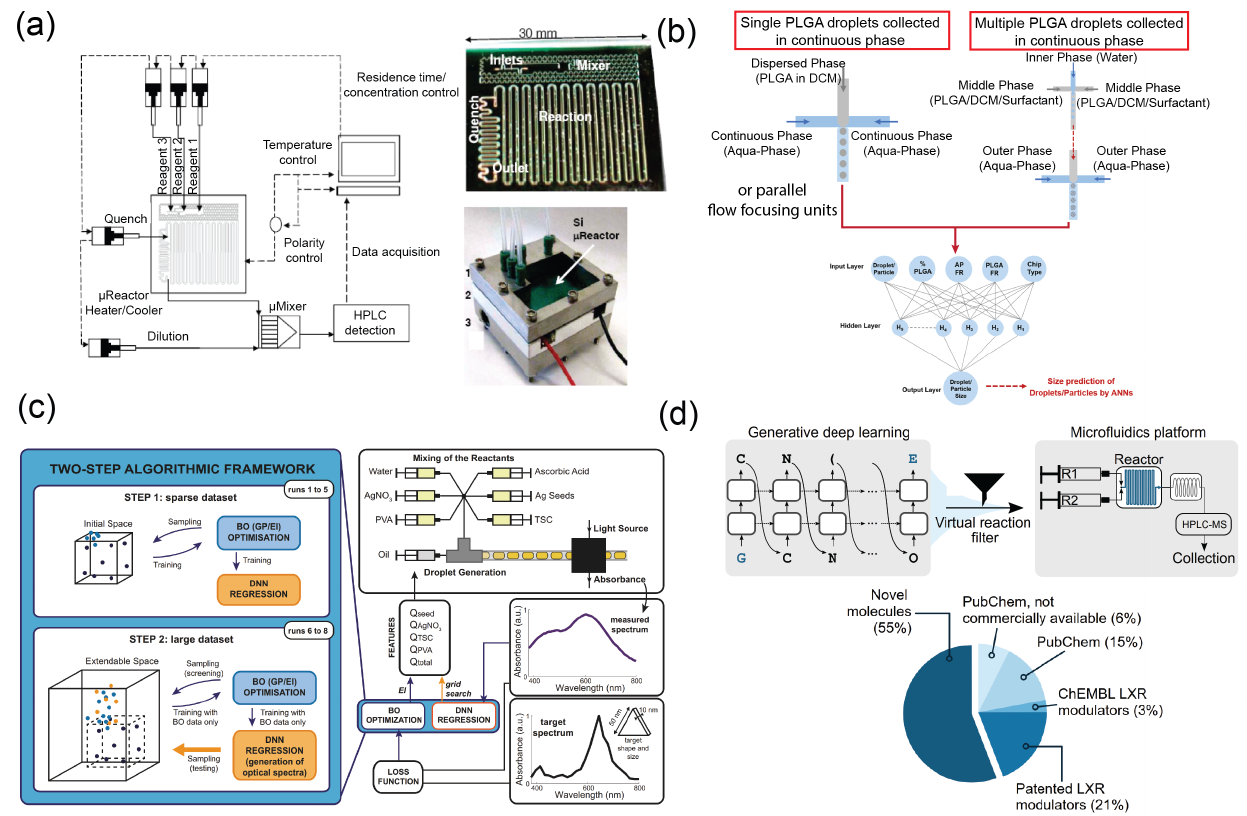
Figure 3. Microfluidics integrated with machine learning for process optimization and drug discovery. ( a ) An automated microfluidic system for automated optimization of chemical synthesis.